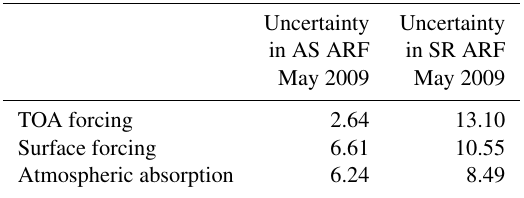
Table A2. The rms uncertainty in direct aerosol radiative forcing over the Indian region for May